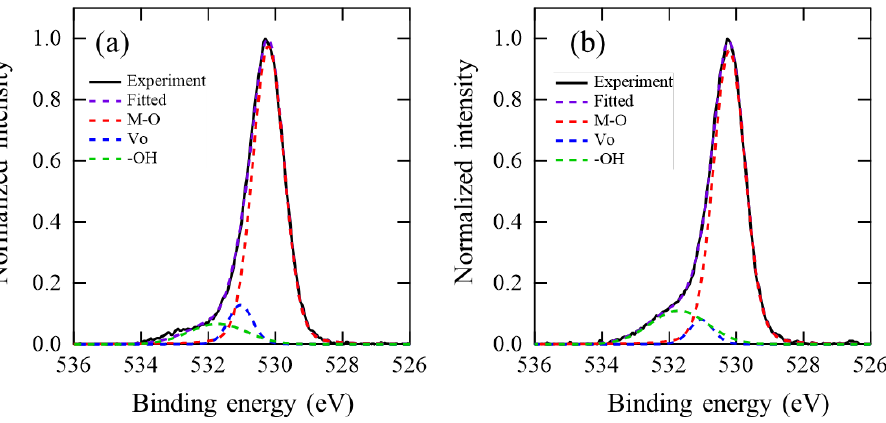
Figure 7. O 1s HXPS spectra obtained from ( a ) poly-InO x and ( b ) poly-InO x :H (R[H 2 ] = 5%) films after PDA in air at 250 °C.